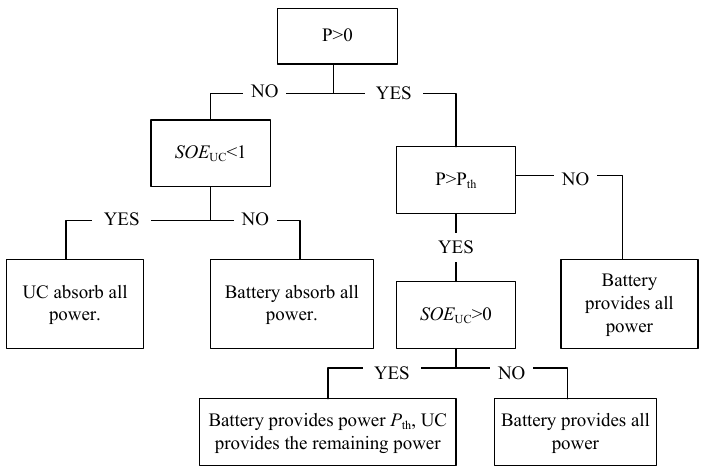
Figure 10. Schematic diagram of the rule-based strategy.